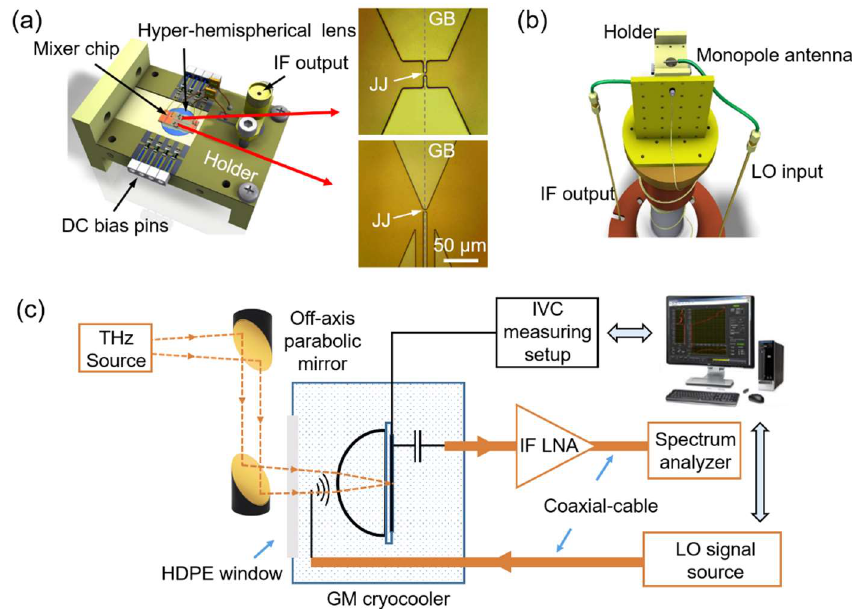
Figure 4. ( a ) Mixer chip on a sample holder with packaged modules. ( b ) Three-dimensional view of the monopole antenna at LO input in a GM cryocooler. ( c ) Schematic diagram of the measurement setup for harmonic mixing.